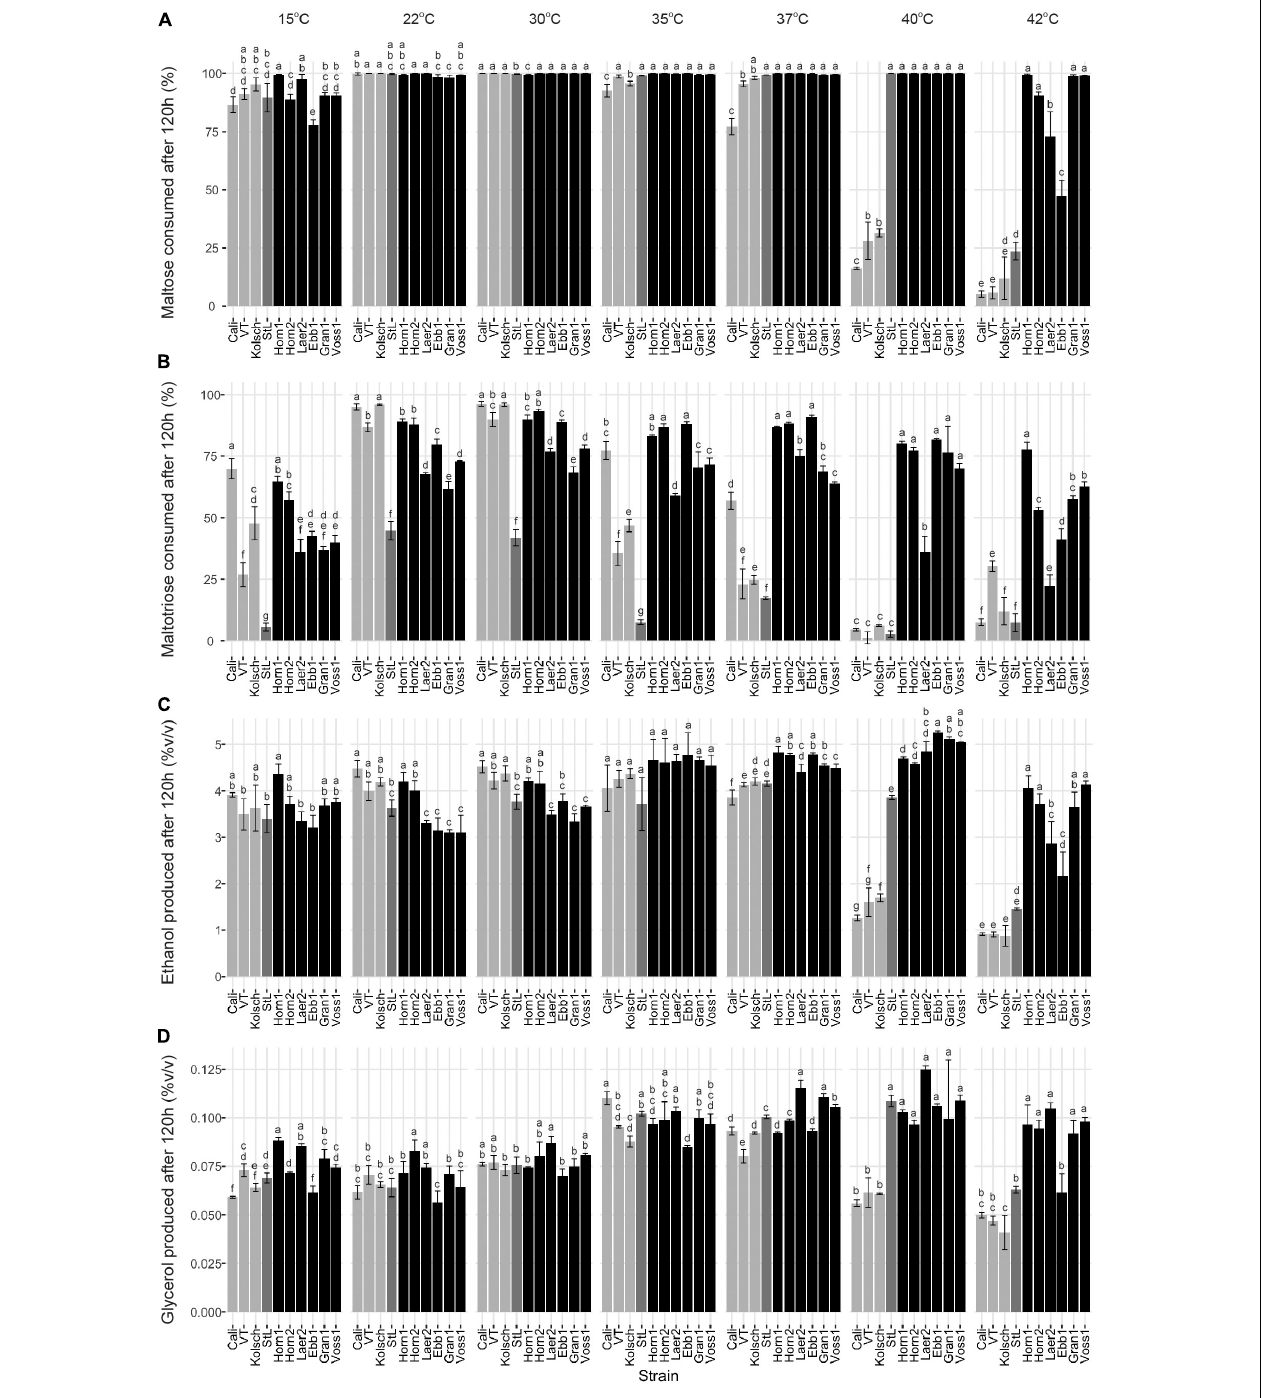
FIGURE 6 | Final wort sugar consumption and ethanol and glycerol production of six Norwegian kveik strains and four commercial Saccharomyces cerevisiae beer strains after the fermentation in Figure 2 . Samples were collected for HPLC analyses at the same timepoints of SG measurements in Figure 2 . The percentage (%) of total sugar consumed after 120 h of fermentation are presented for (A) maltose and (B) maltotriose, and the amount of (C) ethanol, and (D) glycerol produced. Data points represent the mean of biological replicates ( n = 3) and error bars represent the SD. Data was subjected to one-way ANOVA followed by Tukey’s HSD analysis of the mean sugar consumption and metabolite production between strains for each timepoint and temperature (Concentration ∼ Strain). Mean values assigned with a common letter are not significantly different by the HSD-test at the 5% level of significance within the same temperature. Light gray bars are Beer 1, dark gray bars are Beer 2, and black bars are kveik